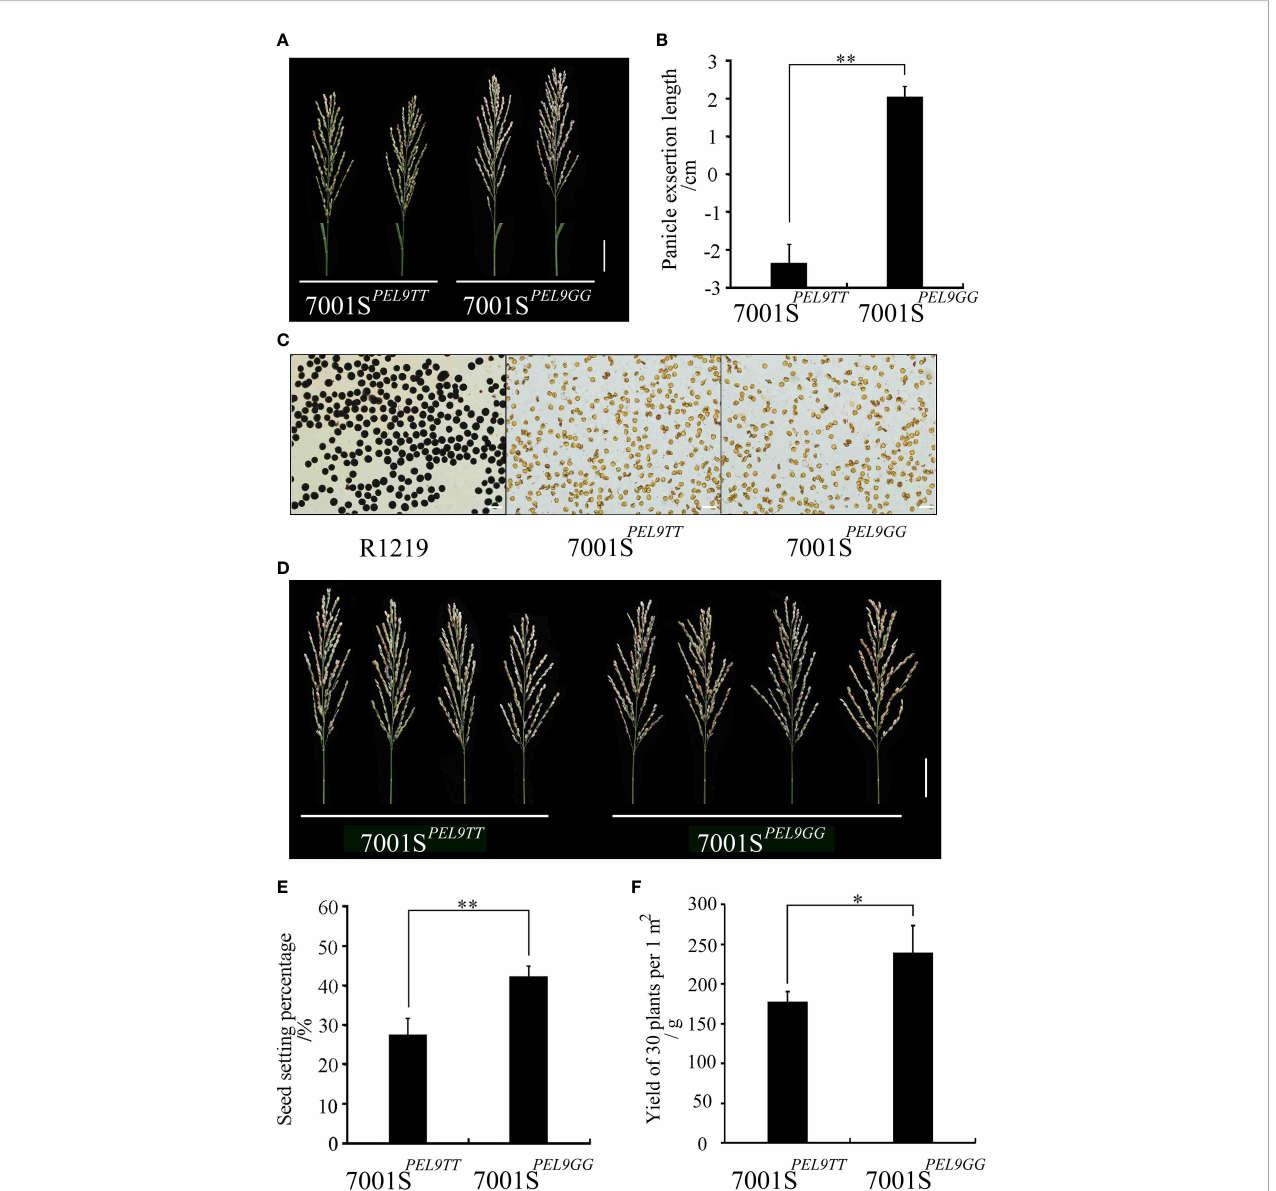
FIGURE 5 Hybrid rice seed production evaluation of PEL9 gene. (A) Panicle morphology of 7001S PEL9TT and 7001S PEL9GG . Scale bar, 5 cm. (B) Comparison of the PELs of 7001S PEL9TT and 7001S PEL9GG . Data represent means ± SD (n = 35 independent plants), ** P < 0.01, Student ’ s t -test. (C) Pollen viability test. Fertile pollen grains of R1219 could be stained by 1% I 2 -KI, while abortive pollen grains of 7001S PEL9TT and 7001S PEL9GG could not be stained. Scale bar, 100 m m. (D) F 1 panicle morphology of 7001S PEL9TT × R1219 and 7001S PEL9GG × R1219. Scale bar, 5 cm. (E) Comparison of the seed setting percentages of 7001S PEL9TT and 7001S PEL9GG after arti fi cial supplementary pollination. Data represent means ± SD (n = 30 independent plants), ** P < 0.01, Student ’ s t - test. (F) Comparison of the yield of 30 plants per 1 m 2 of 7001S PEL9TT and 7001S PEL9GG after arti fi cial supplementary pollination. Data represent means ± SD (n = 30 independent plants), ** P < 0.01, Student ’ s t